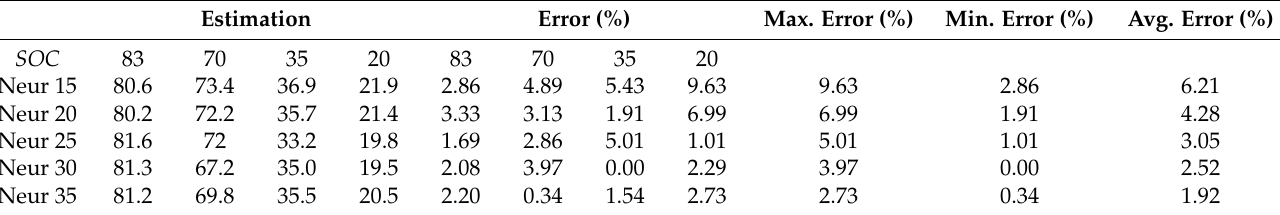
Table 4. Output SOC of ANN-based and target SOC